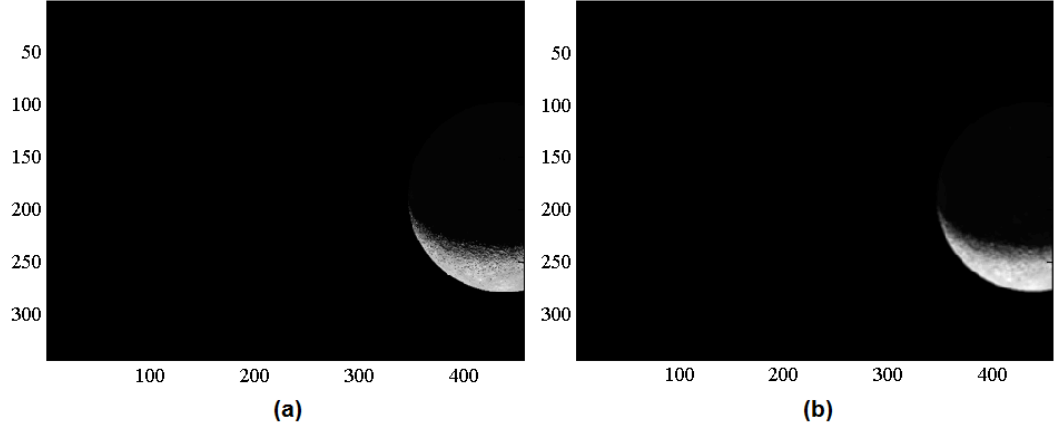
Figure 12. Image convolution using a 3 × 3 mask. ( a ): original image; ( b ) convoluted image.